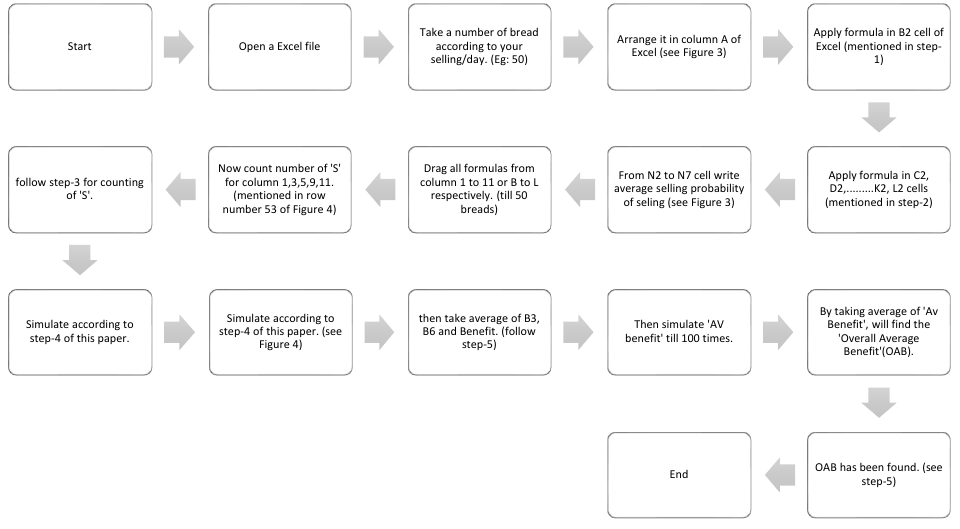
Figure 2. Flowchart of simulation procedure used in this study.